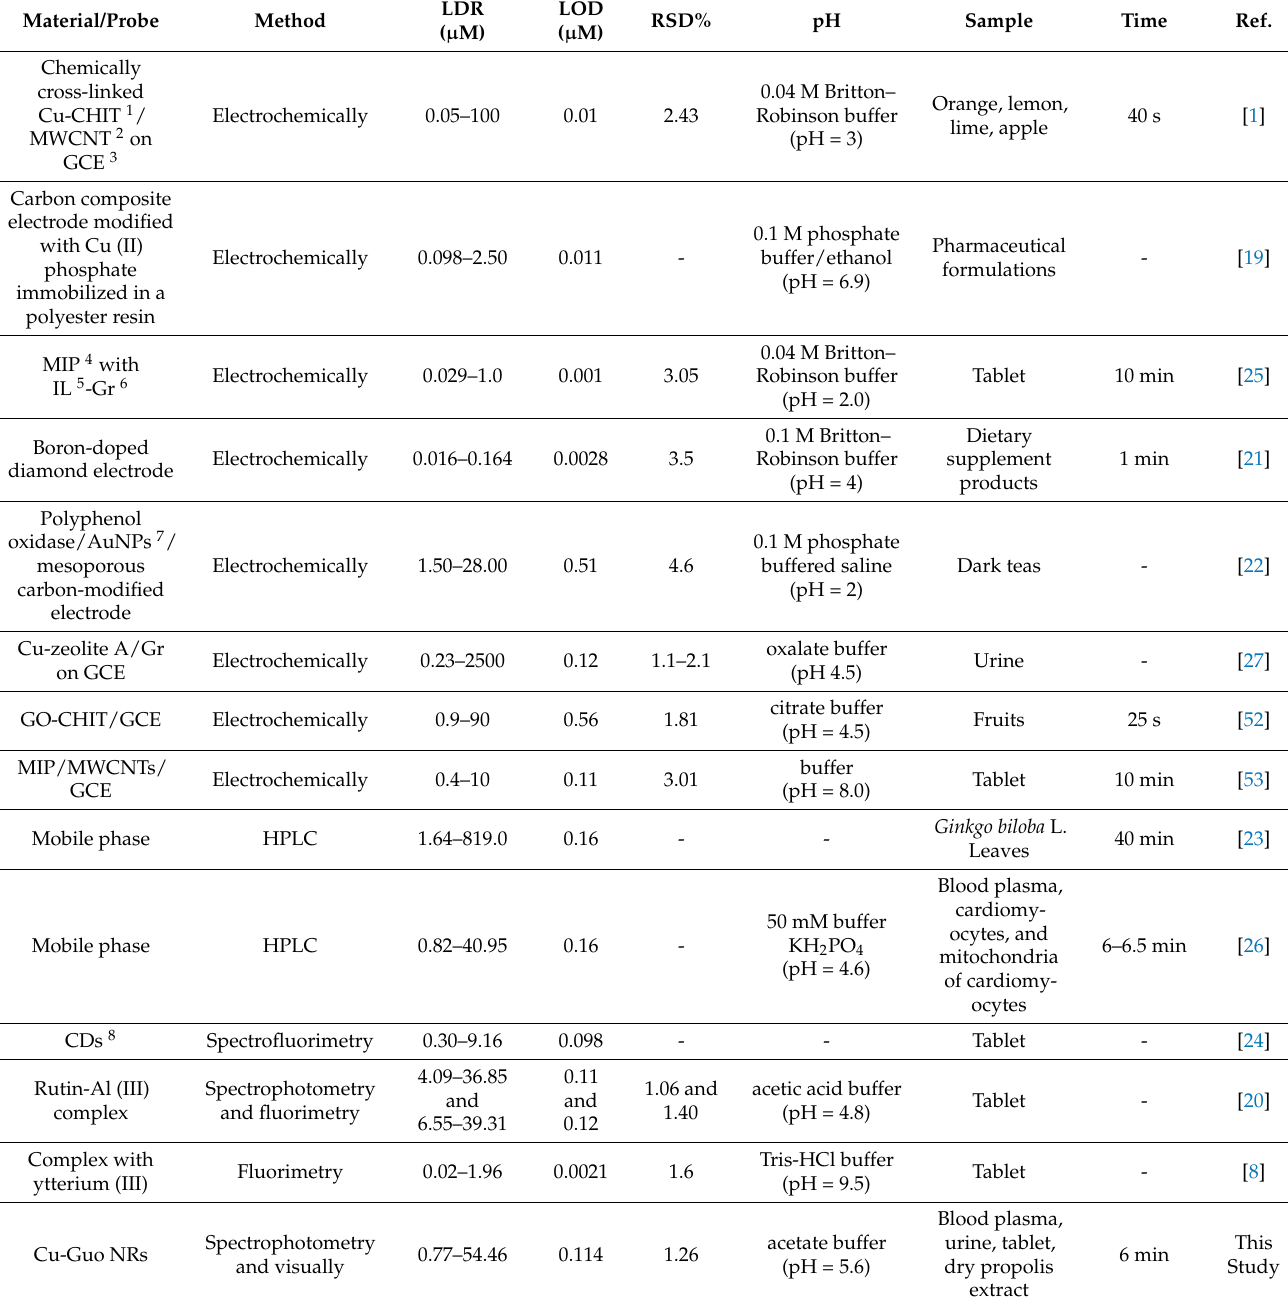
Table 1. Rtn detection based on the proposed colorimetric sensor and other reported